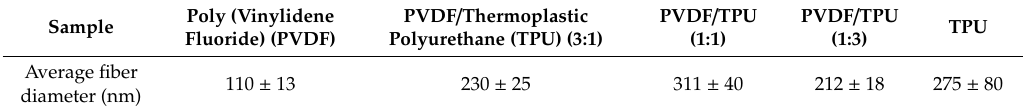
Table 1. Average Fiber Diameter of Nanofibers for Di ff erent PVDF / TPU Composite Membranes.